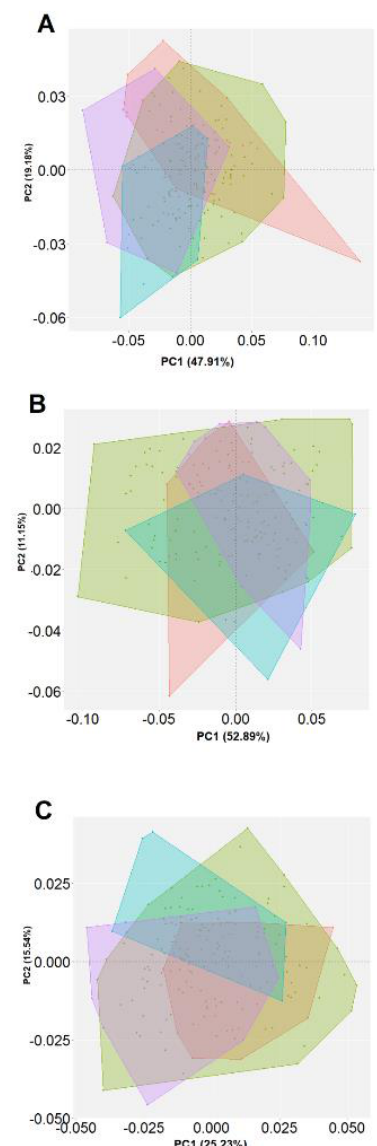
Figure 2. Principal component analysis (PCA) comparing the ( A ) dorsal, ( B ) lateral and ( C ) ventral view of Lottia mesoleuca . The figures show di ff erent colored confident ellipses (95%) for the geographical location red: Isla Gorgona, green: Isla Palma, ligh blue: Los Negritos, purple: Morro